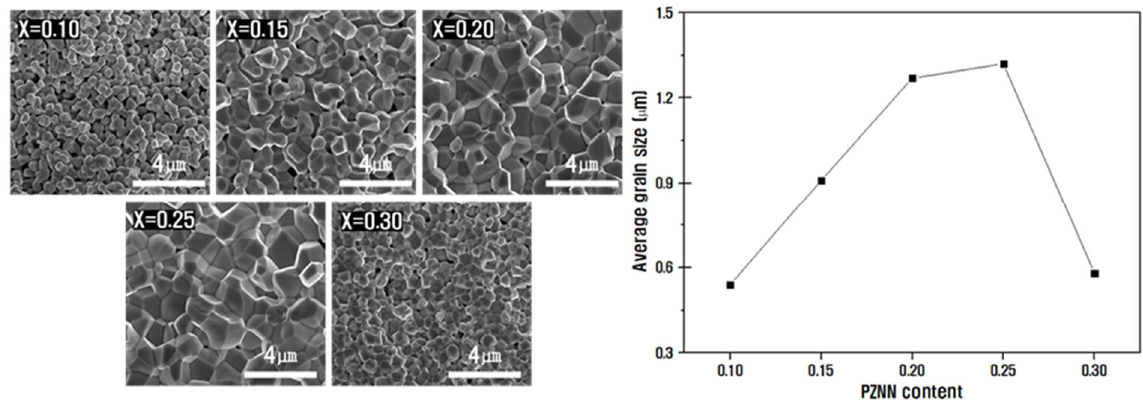
Figure 2. Field emission scanning electron microscopy (FE-SEM) images of the fractured surfaces of the xPb (( Zn 0.8 Ni 0.2 ) Nb 2/3 ) O 3 − ( 1 − x ) Pb ( Zr 0.5 Ti 0.5 ) O 3 ceramics with varying concentrations of PZNN, and the calculated corresponding average particle sizes.